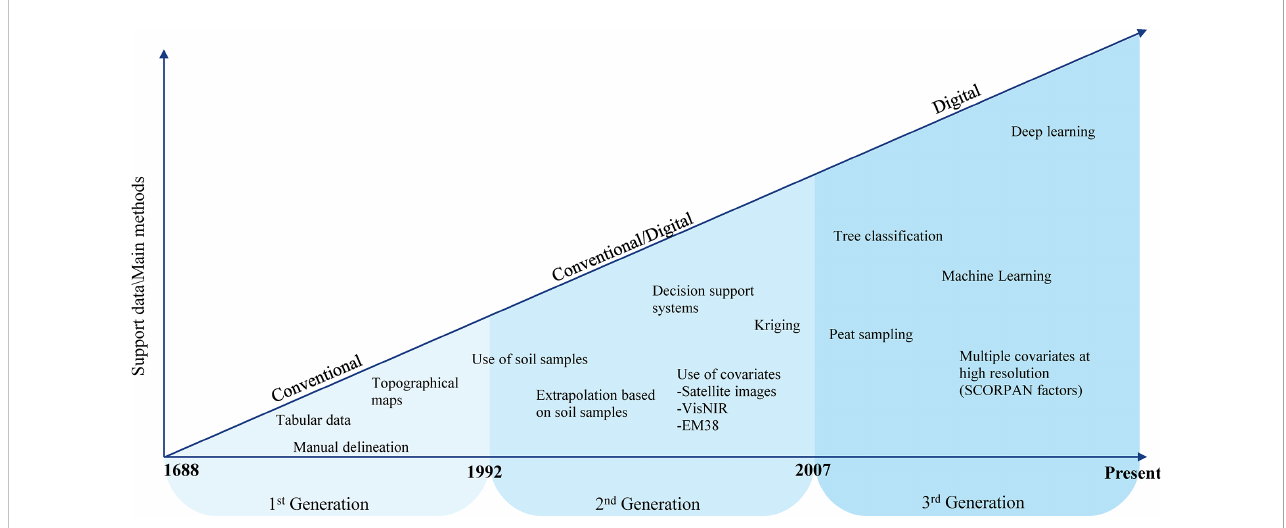
FIGURE 1 Evolution of soil mapping in Denmark highlighting the increase in the availability of support data and the primary use of methods across the three generations of soil maps generated at national